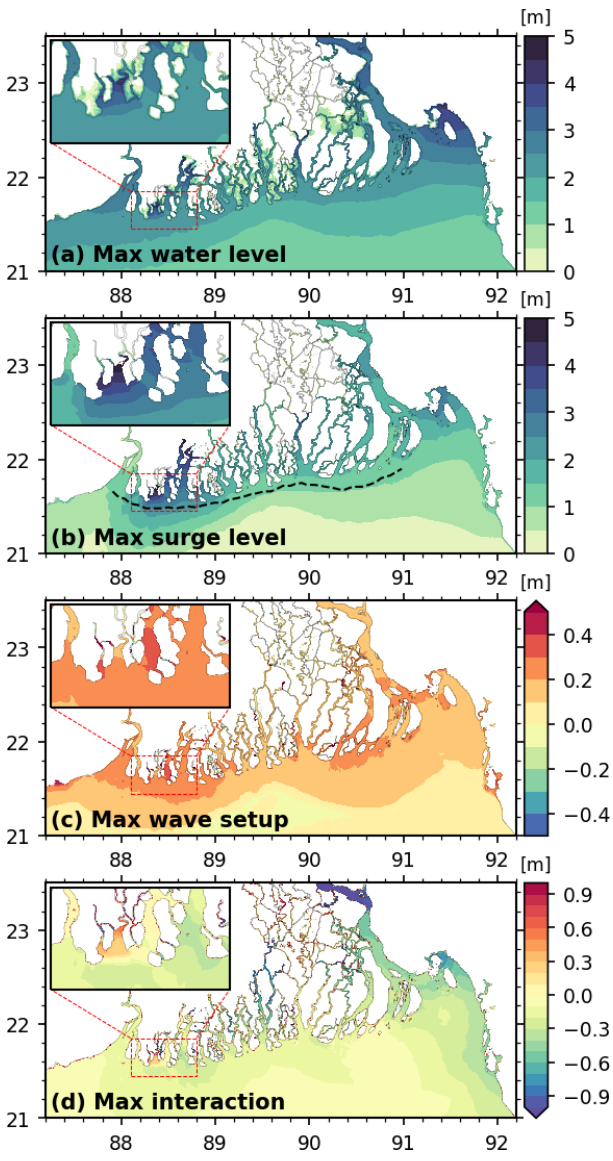
Figure 6. Hindcast of (a) maximum water level, (b) maximum surge, wave set-up and set-down, and (d) maximum non-linear interaction between tide and surge. For (a) , for the areas above mean sea level, the water level is converted to water level above the topography for consistency. The inset maps show a close-up (75km × 45km) of the landfall region. The dashed black line shown in (b) is the segment for error analysis of the forecast experiment in Sect.